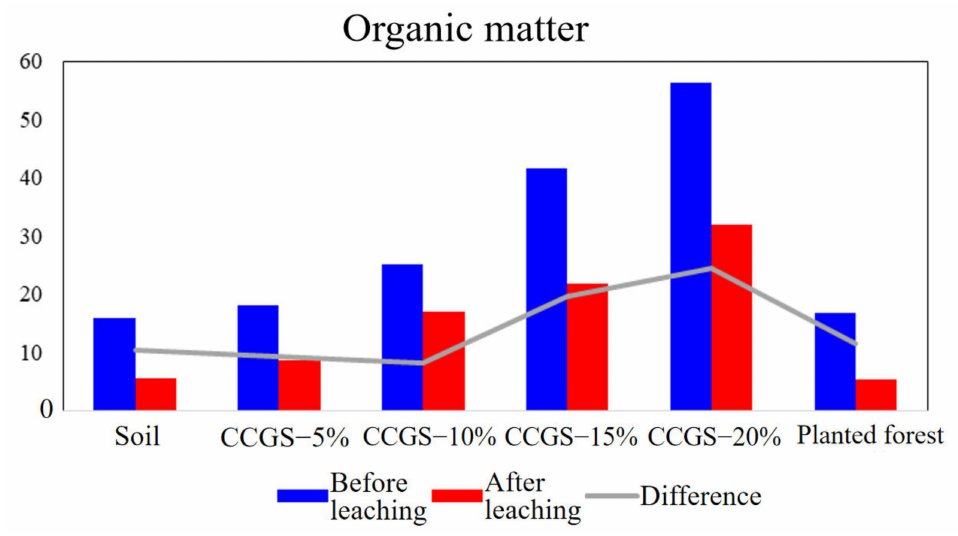
Figure 14. Effect of CCGS on SOM.